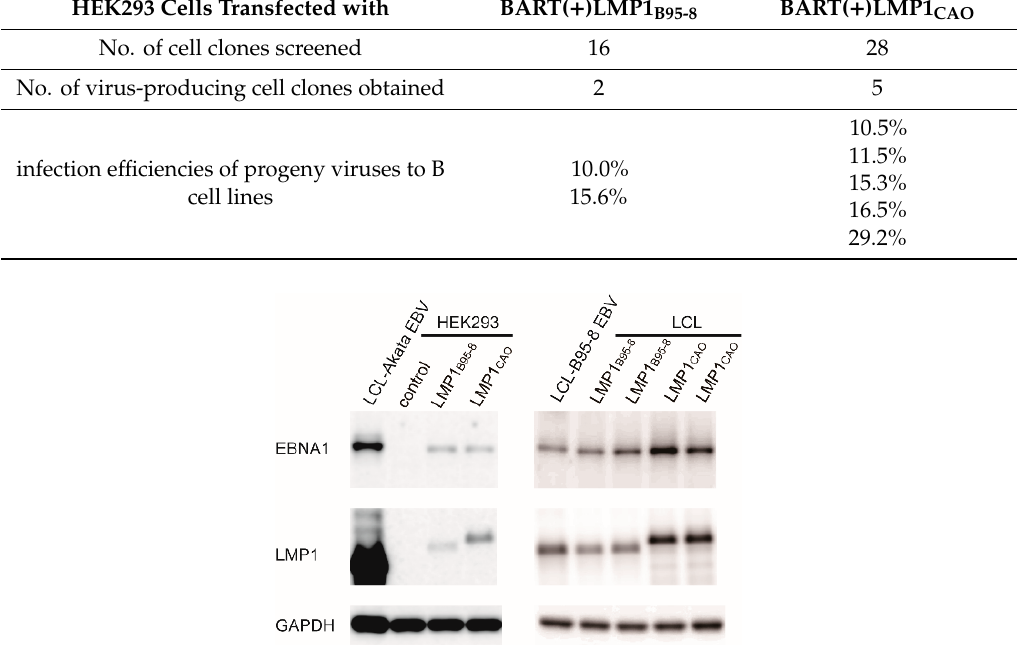
Figure 4. Expression of latent viral proteins by stably transfected HEK293 cells or LCLs. Expression Figure of EBV nuclear antigen 1 (EBNA1) and LMP1 was examined by Western blot analysis.